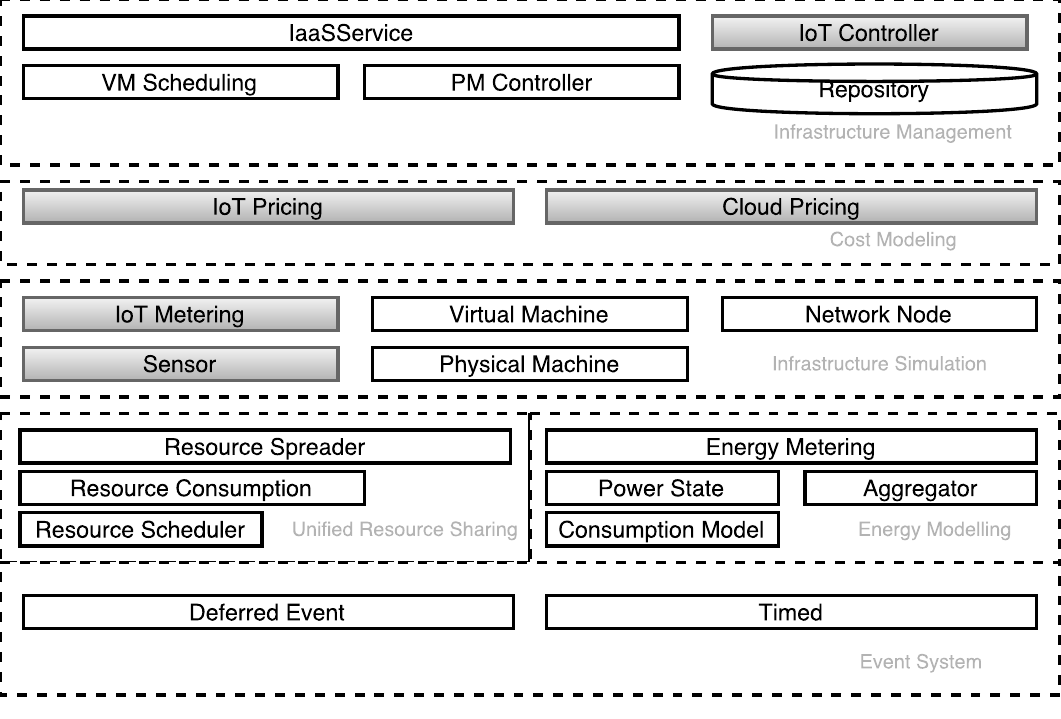
Figure 1. The architecture of the extended DISSECT-CF